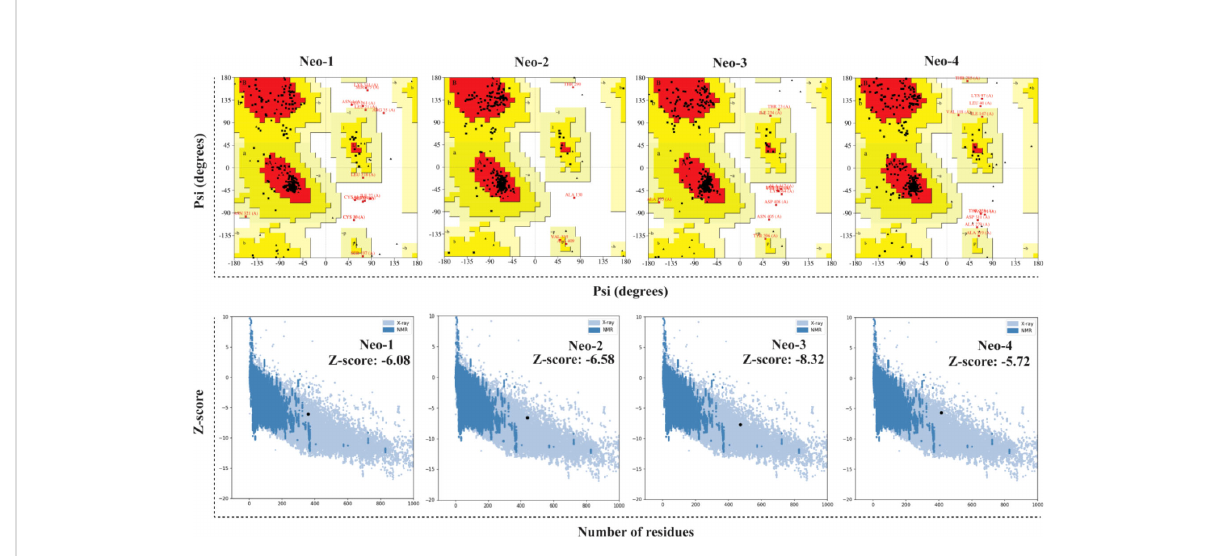
FIGURE 4 Validation of the predicted 3D structure models of NeoCoV vaccines with PROCHECK and ProSA-webserver.